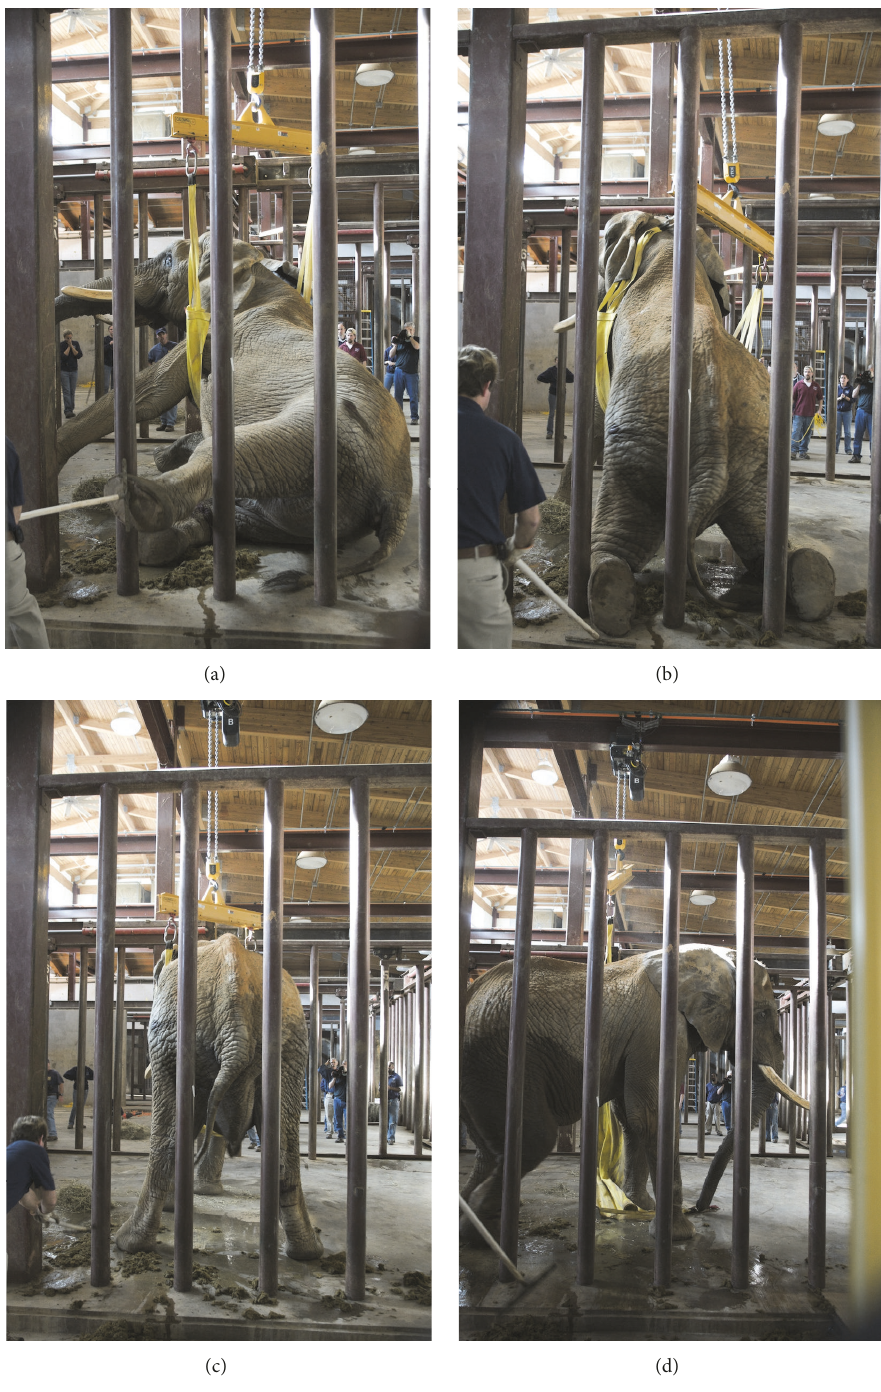
Figure 10: A series of images illustrating the use of an overhead hoist attached to a sling that was placed under his thorax prior to induction (see Figure